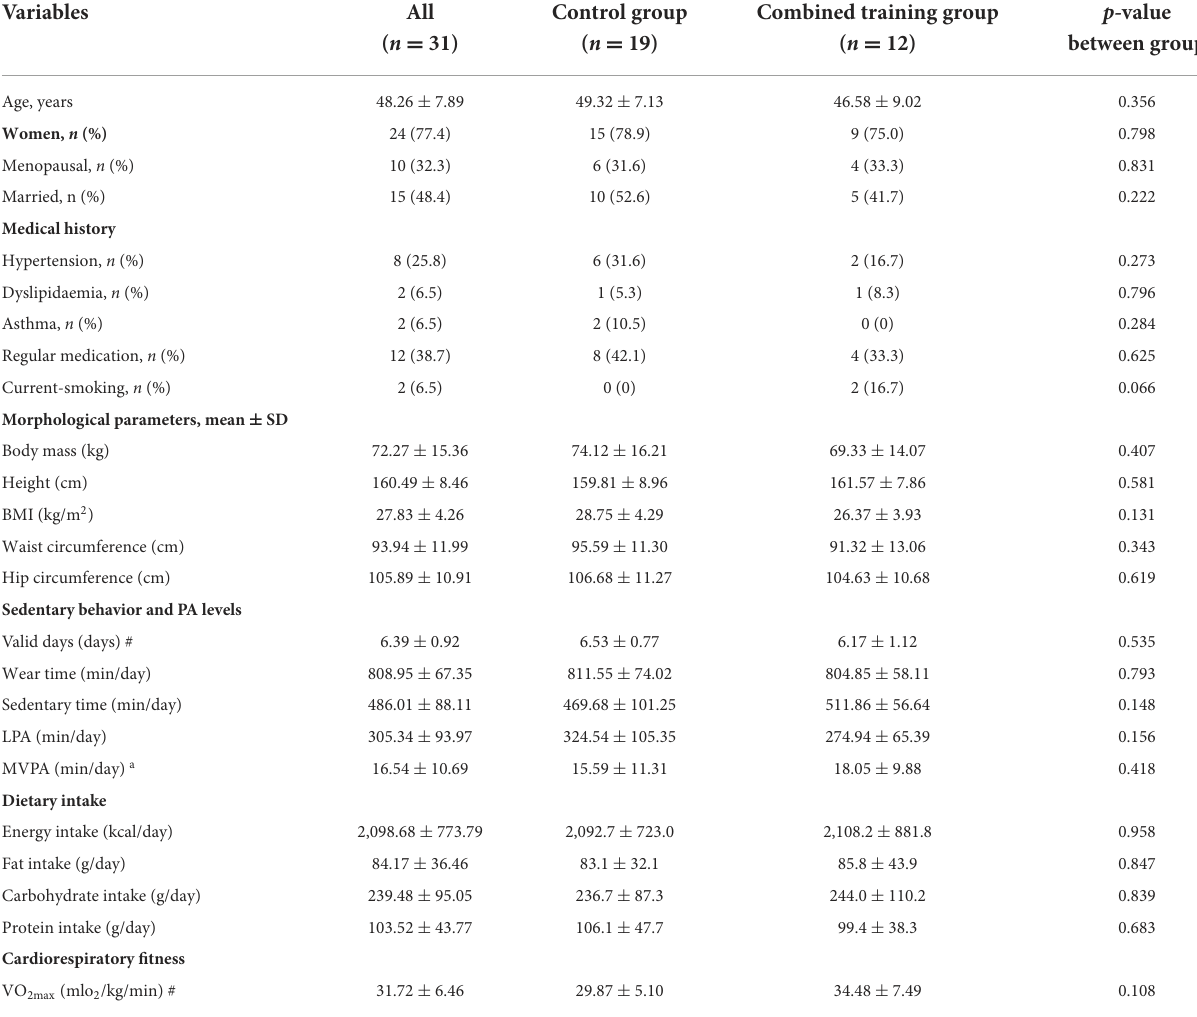
TABLE 1 Baseline characteristics of all the study participants and after their randomization into control or the combined training protocol.